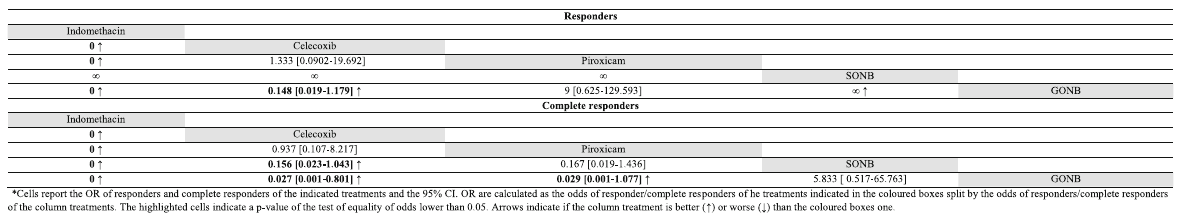
Table 2 comparisons between the odds of partial and complete responders for the acute treatments of HC*